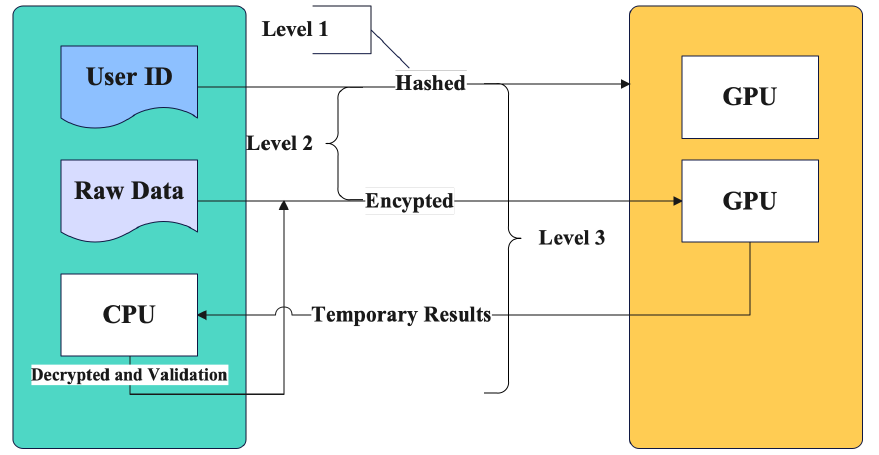
Figure 2. Illustration of protection levels supported by proposed